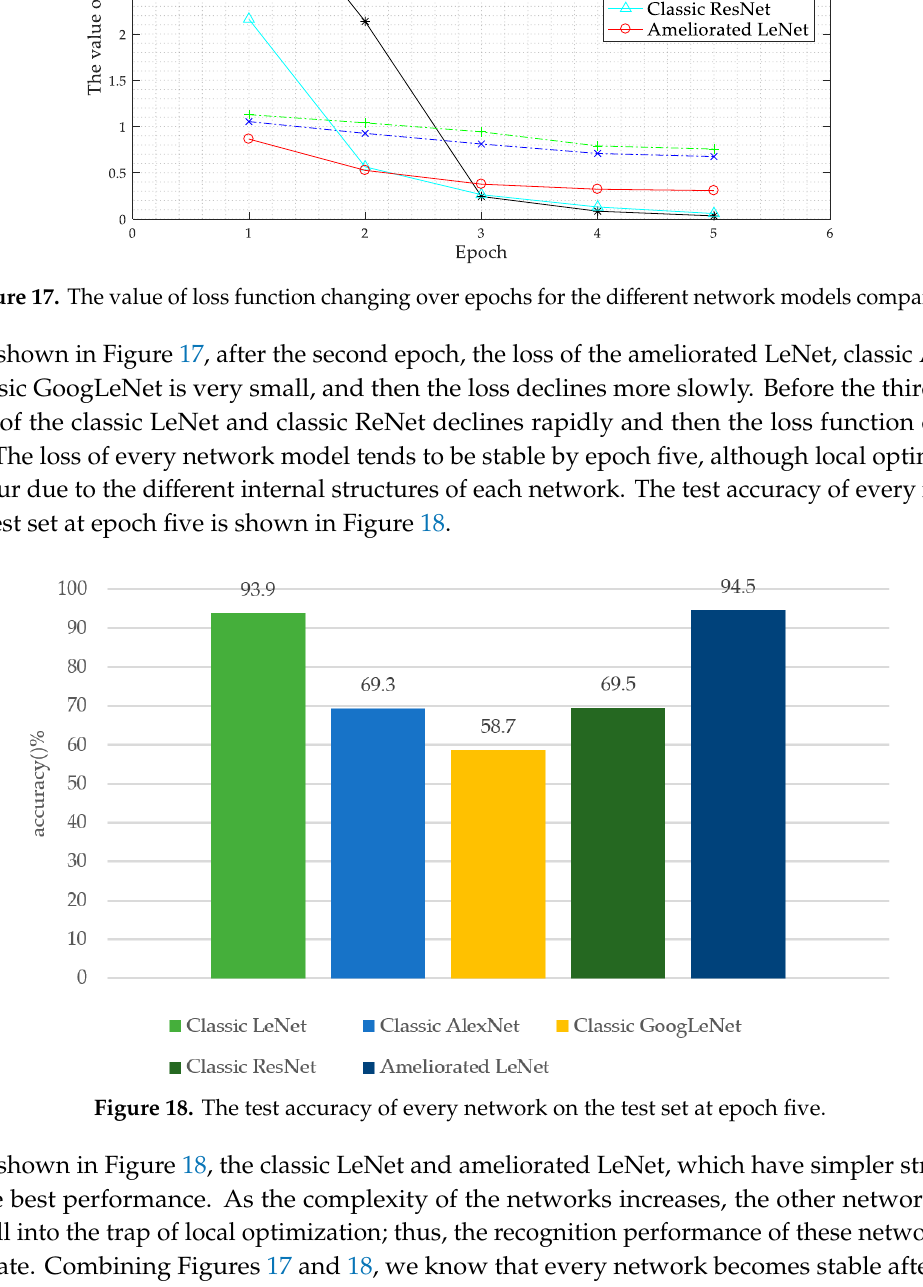
Figure 18. The test accuracy of every network on the test set at epoch five.